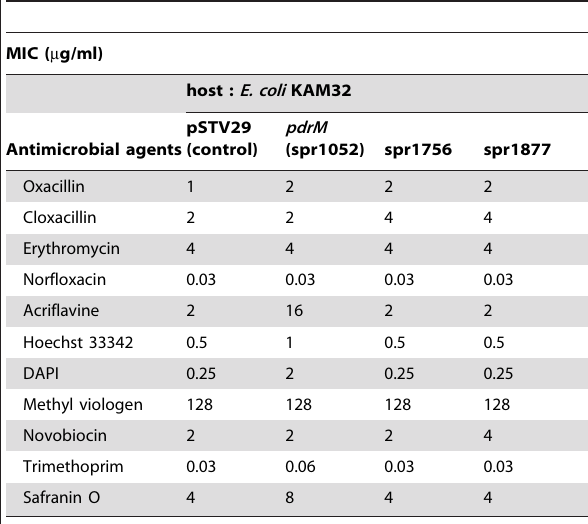
Table 3. Drug susceptibility in cells transformed with genes predicted from genome